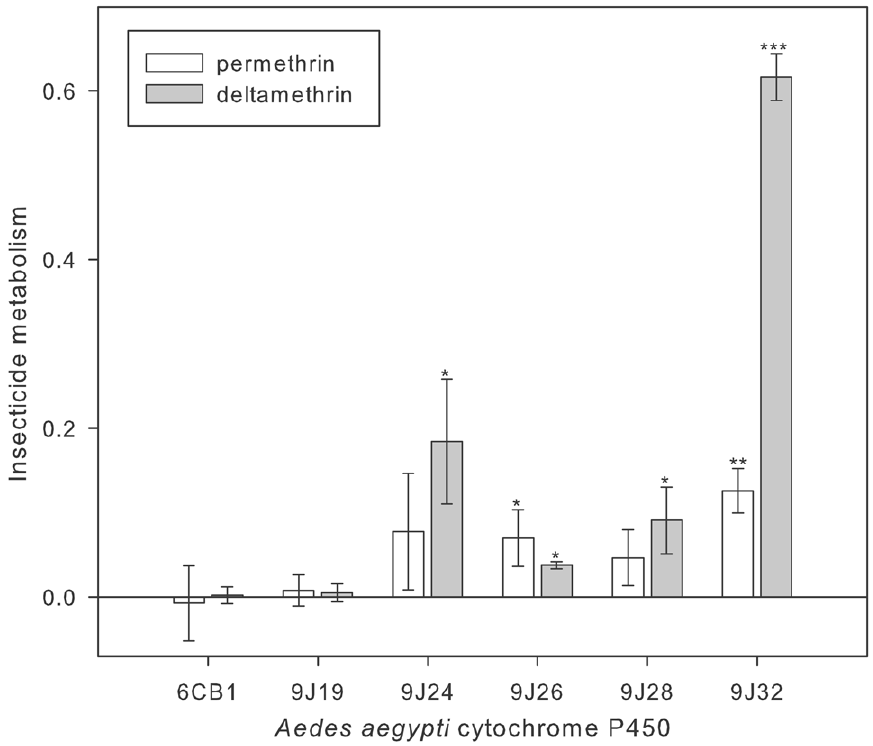
Figure 2. Permethrin and deltamethrin metabolism by Aeaegypti P450s. The proportion of 10 m M insecticide cleared by 0.1 m M P450 with 0.8 m M cyt b5 in the presence of NADPH is indicated by bar height. Error bars represent standard deviation (N=3) and significantly greater insecticide clearance compared to negative reactions (no NADPH supplied) are indicated: * P , 0.05, ** P , 0.01, or *** P , 0.001 (paired T-test).